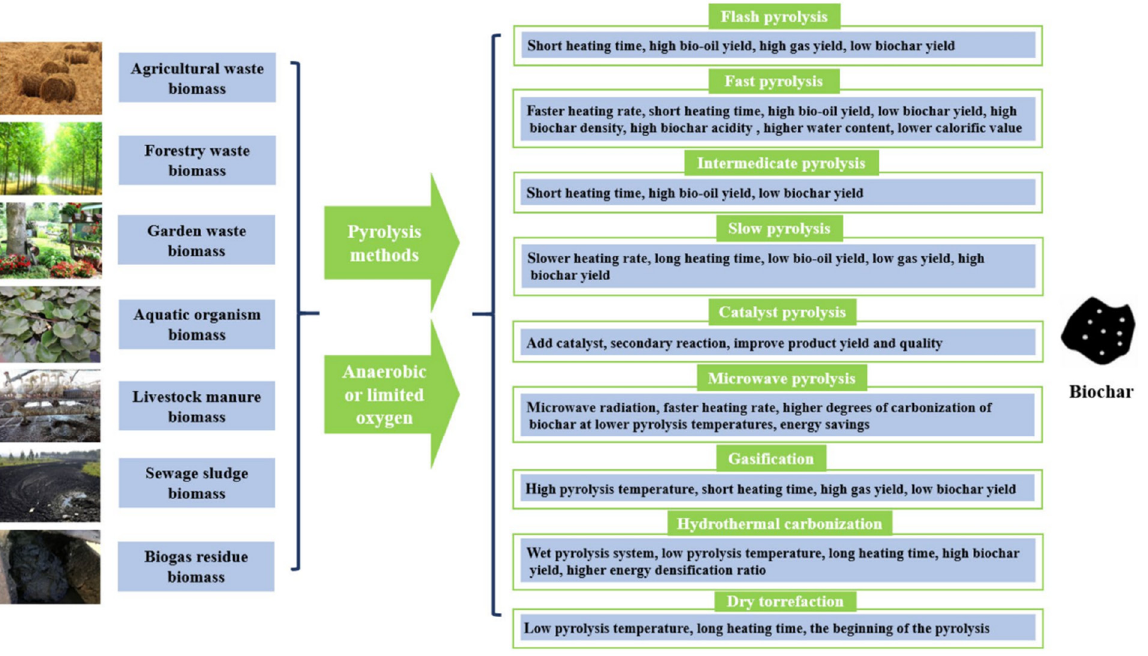
Figure 1. Summary of various preparation methods of biochar [68]. Reprinted with permission from Yuxin Jiao et al. (2021). Copyright 2021, Springer.